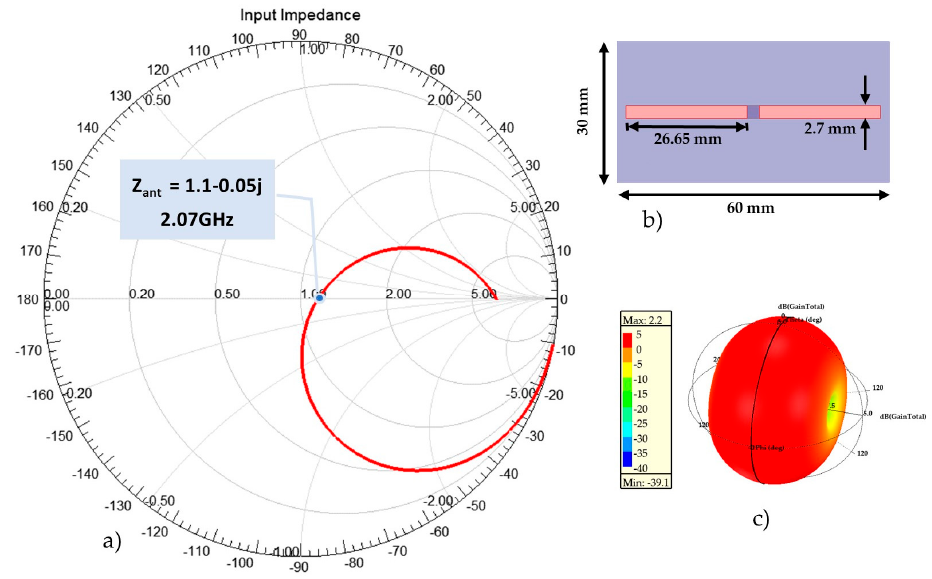
Figure 1. Conventional dipole antenna simulated on the required size dimensions. ( a ) The input impedance representation on Smith chart; ( b ) Half-wavelength antenna dimensions; ( c ) Simulated 3D radiation pattern at 2 GHz.